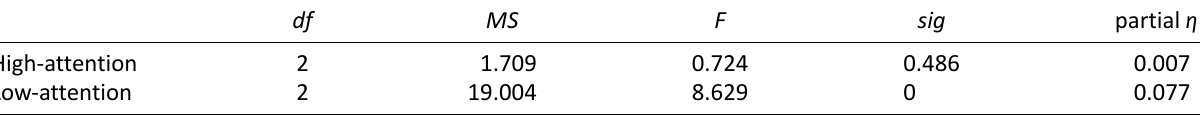
Table 9. Different IP effects on high and low‐attention’s coherence values. df MS F sig